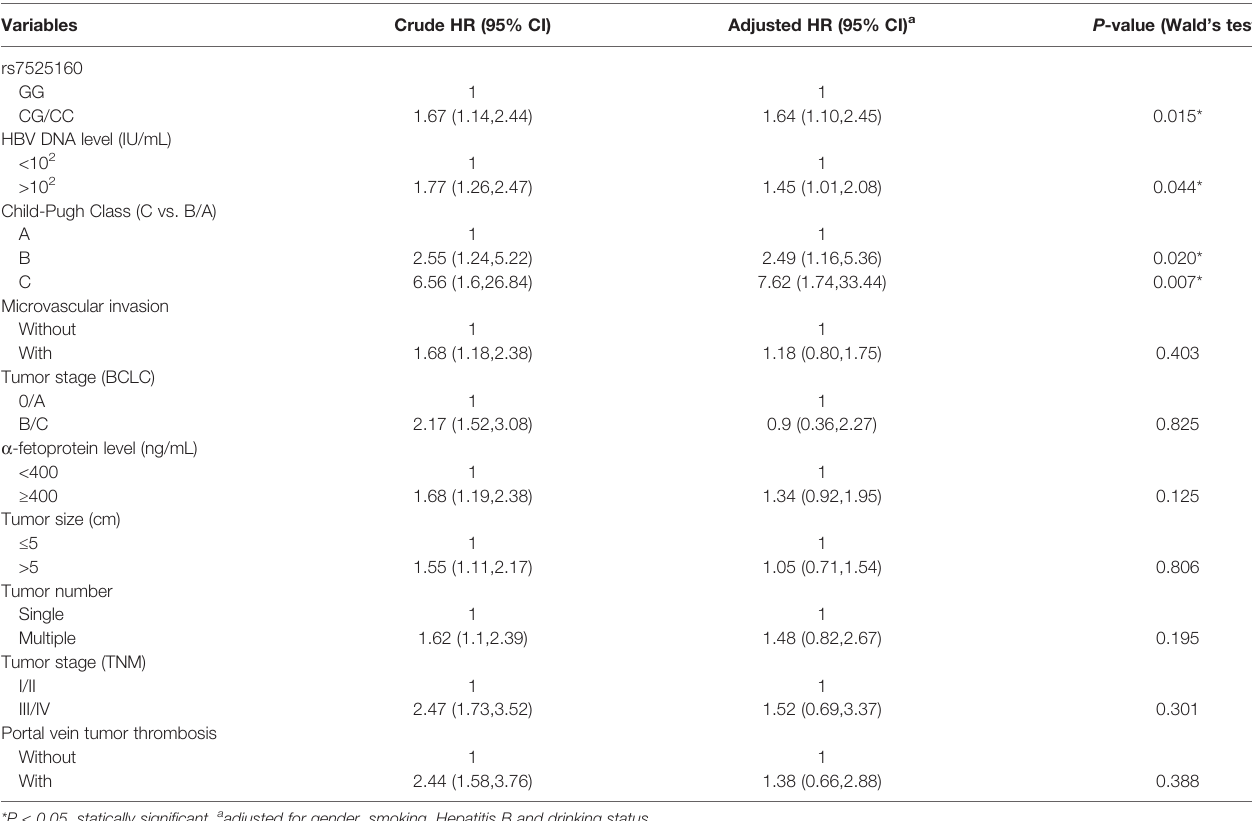
TABLE 4 | Cox analysis of potential factors for recurrence analysis in patients with resected HCC.